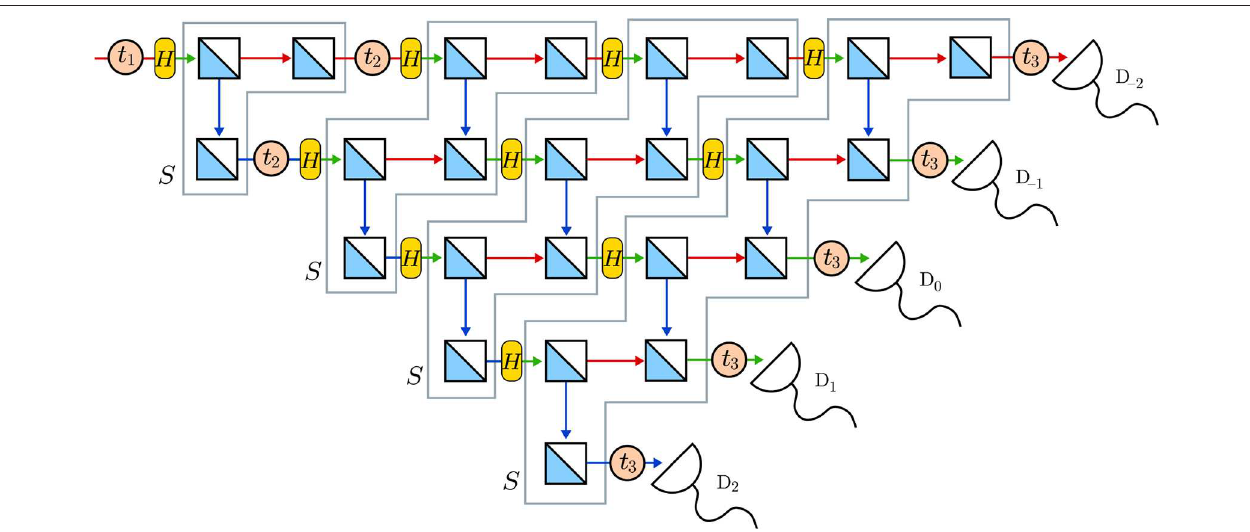
FIGURE 3 | DES setup for the QW with polarized single photons of the same energy. Red horizontal (blue vertical) lines show the path of h ( v ) polarized photons. Green lines represent the path of photons with a linear combination of h and v polarization. The input to the network consists of h polarized photons only. Square (blue/white) boxes represent polarizing beam splitters. The oval (yellow) boxes perform a Hadamard transformation on the photon polarization. Each gray region corresponds to a single-atom jump operation in the QW experiment [1]. In quantum theory, the H boxes correspond to Equation (5) and the S regions correspond to Equation (3). Circles with labels t 1 , t 2 , and t 3 denote the positions of the Q ( t 1 ), Q ( t 2 ), and Q ( t 3 ) measurements, respectively.